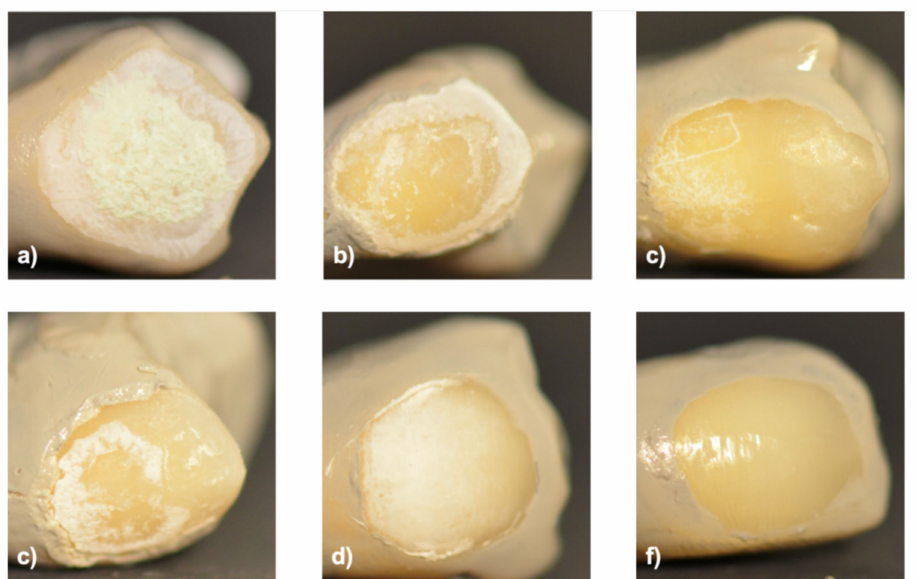
Figure 4. The enamel after being placed for 24 h in: ( a ) hydrochloric acid; ( b ) orthophosphoric acid; ( c ) lactic acid; ( d ) orthophosphoric acid solution; ( e ) formic acid; ( f ) CaCl 2 , NaH 2 PO 4 and acetic acid solution.